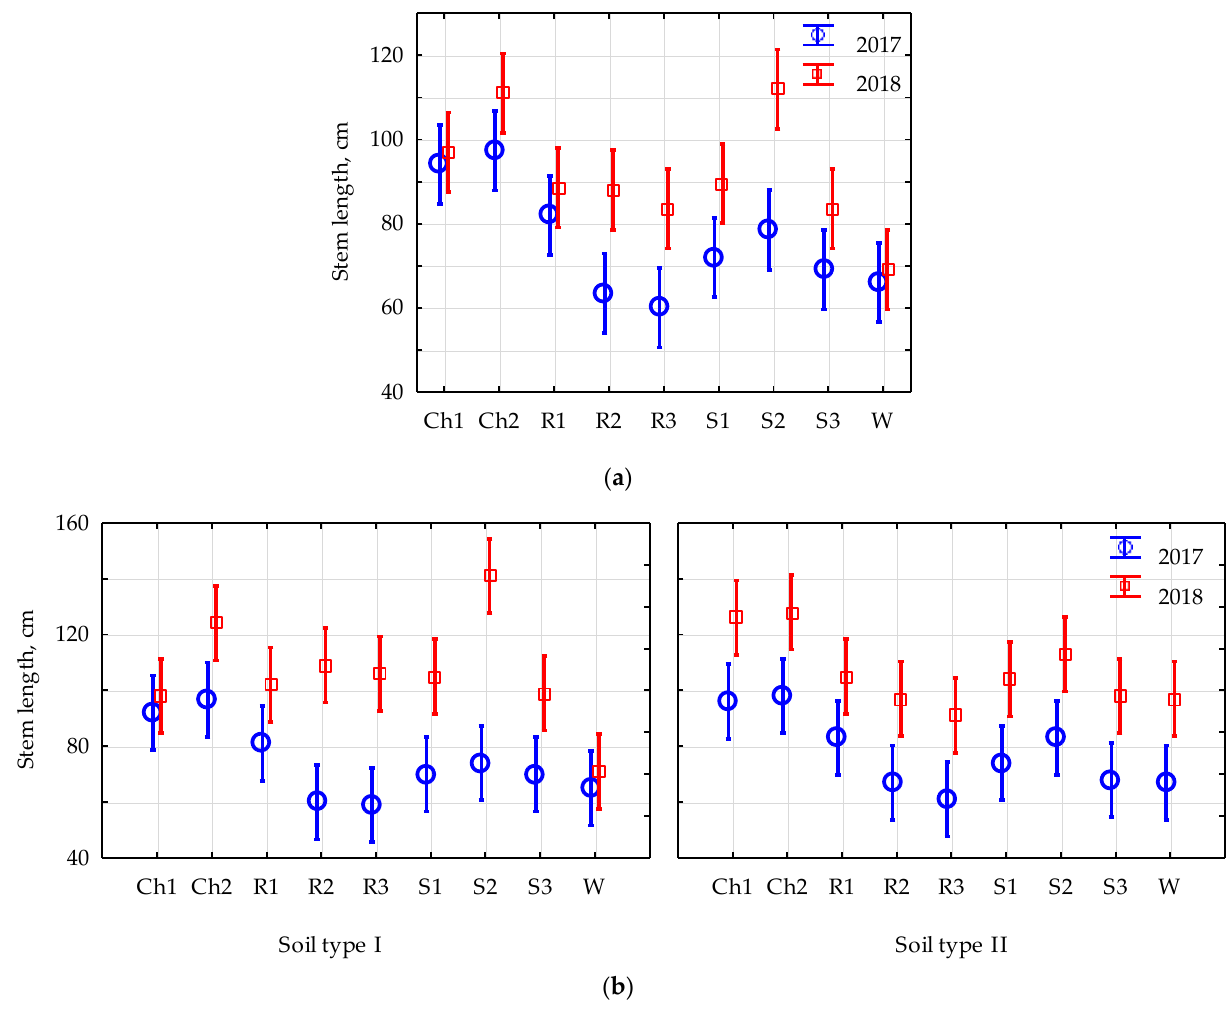
Figure 1. The impact of the various treatments of PGRs on stem length ( a ) depending on the soil type ( b ). Squares and circles show least-squares means. Vertical bars denote 0.95 confidence intervals. Table 4. Evaluation of the effect of the research factors, PGRs, soil type, and year of vegetation, on M. × giganteus bioparameters following M-GLM